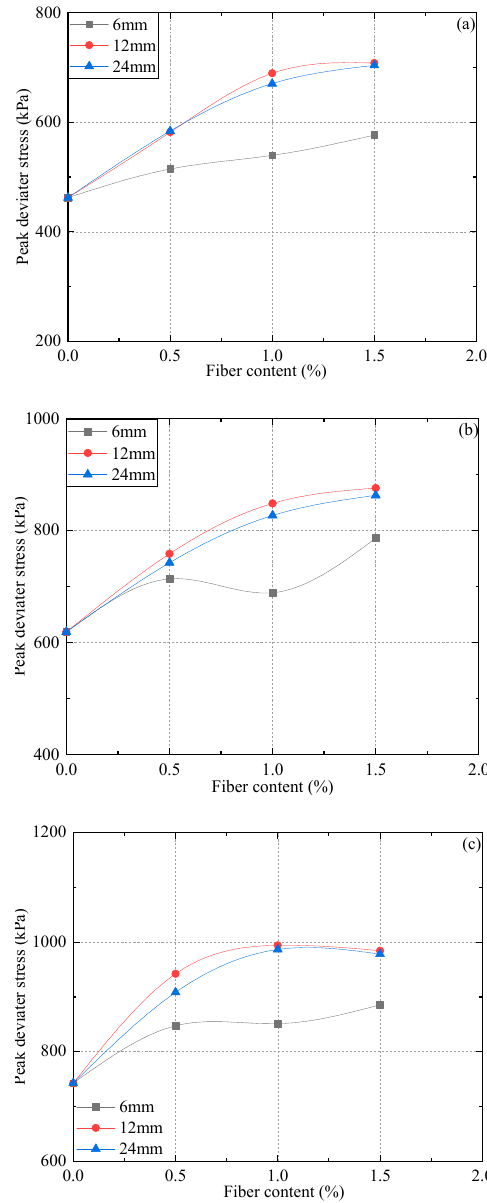
Figure 8. Effects of different FL and FC on the peak deviator stress of FAS specimens: ( a ) 200 kPa, ( b ) 300 kPa, ( c ) 400 kPa.